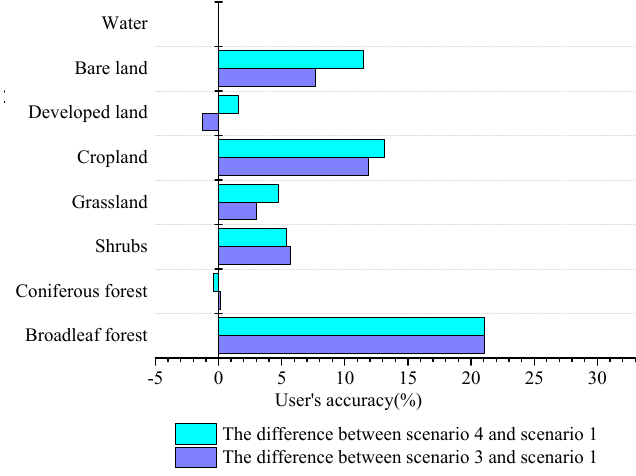
Figure 9. The differences in user’s accuracy between scenarios.